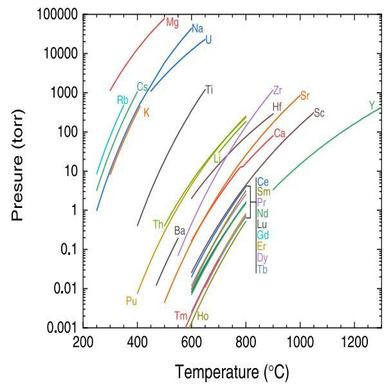
Plateau pressures of the monohydrides and dihydrides of various metals .